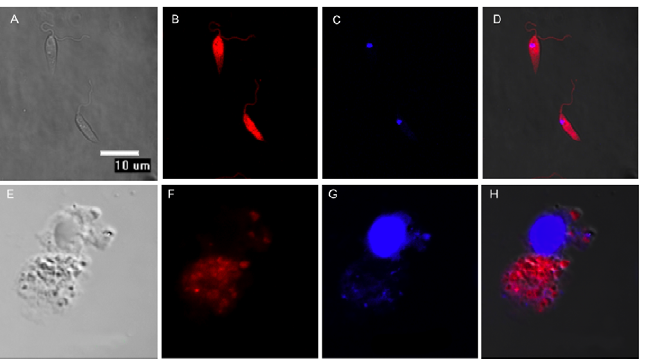
Figure 3. Fluorescent detection of mCherry + L.major transfected parasites by confocal microscopy. Top panel (A, B, C, D) L. major promastigotes. Bottom panel (E, F, G, H) BALB/c mouse peritoneal macrophages experimentally infected with mCherry + L. major metacyclic promastigotes. (A, E) Differential Interference Contrast (DIC); (B, F) mCherry + L. major emitting red fluorescence; (C, G) DAPI staining of nucleic acids; (D, H) merged images. The microscopy images were acquired with a Nikon Eclipse TE2000E confocal microscope.